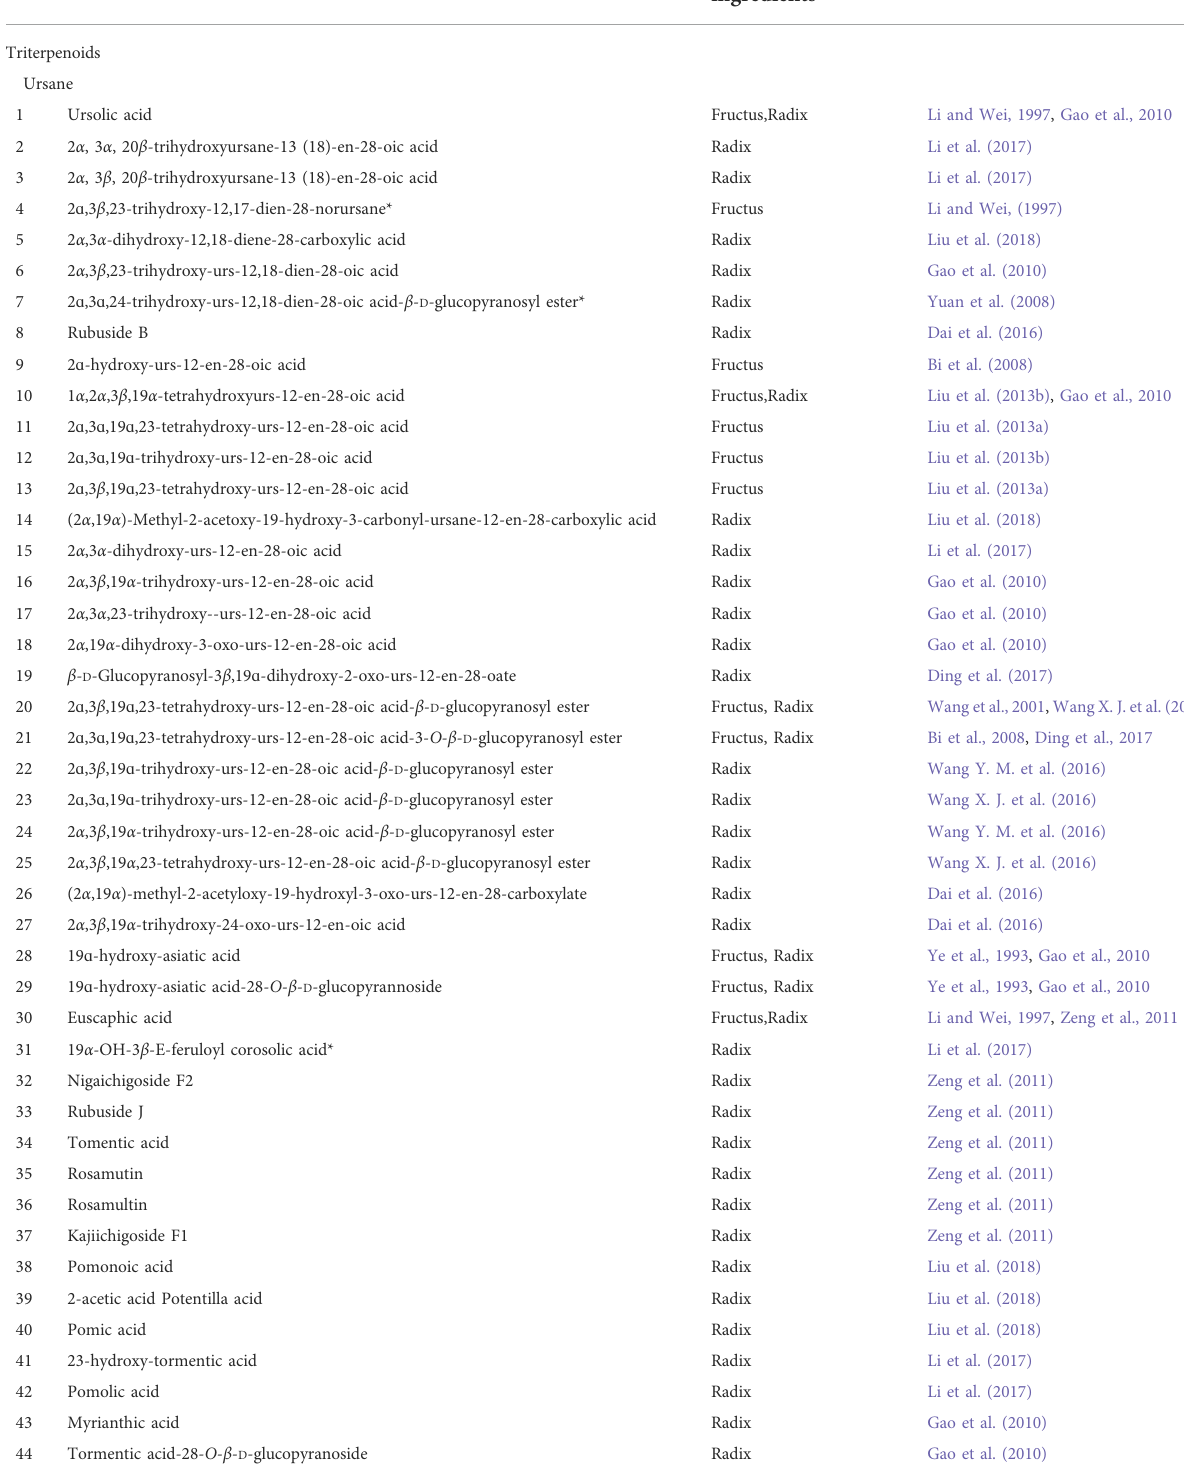
TABLE 1 The composition of R. Laevigata